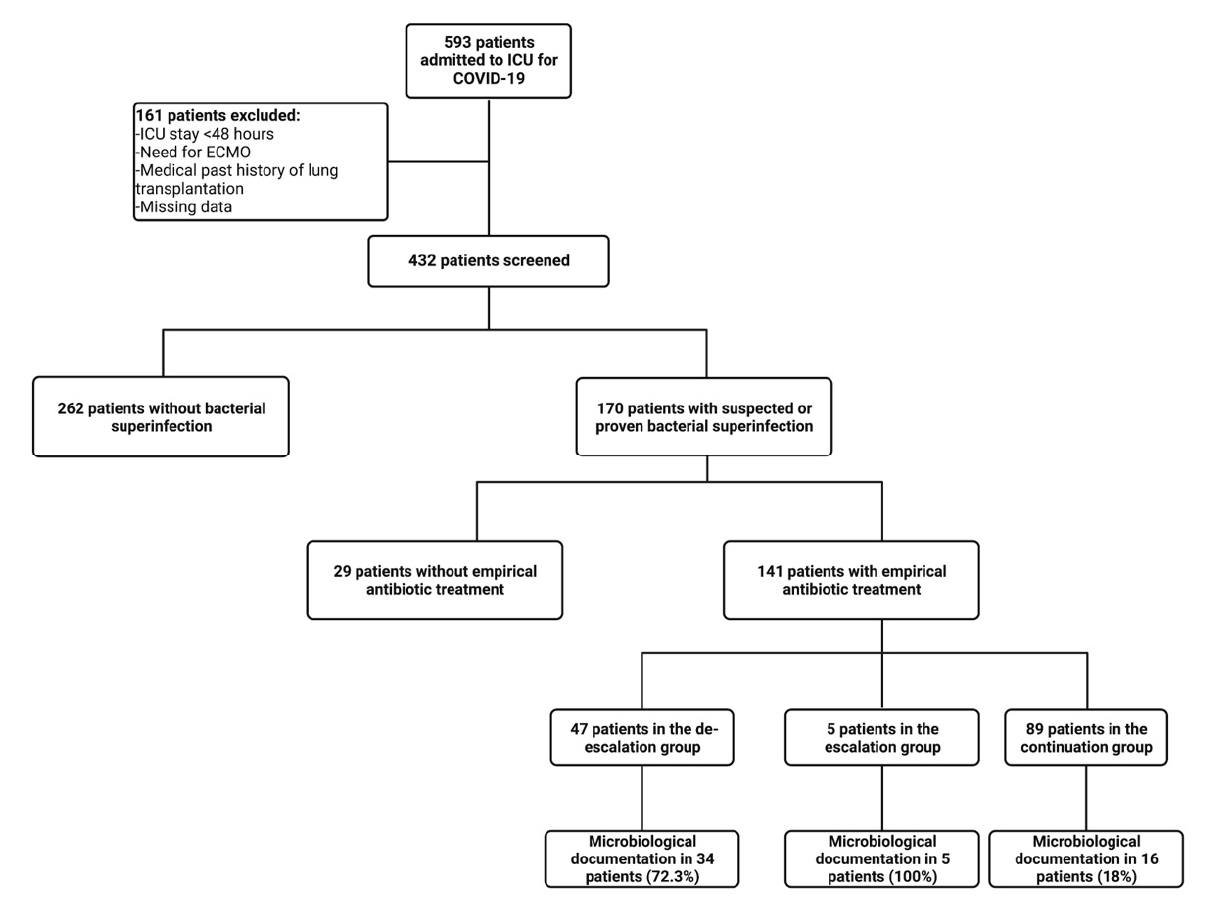
Figure 1. Flow chart of the study. Table 1. Patients